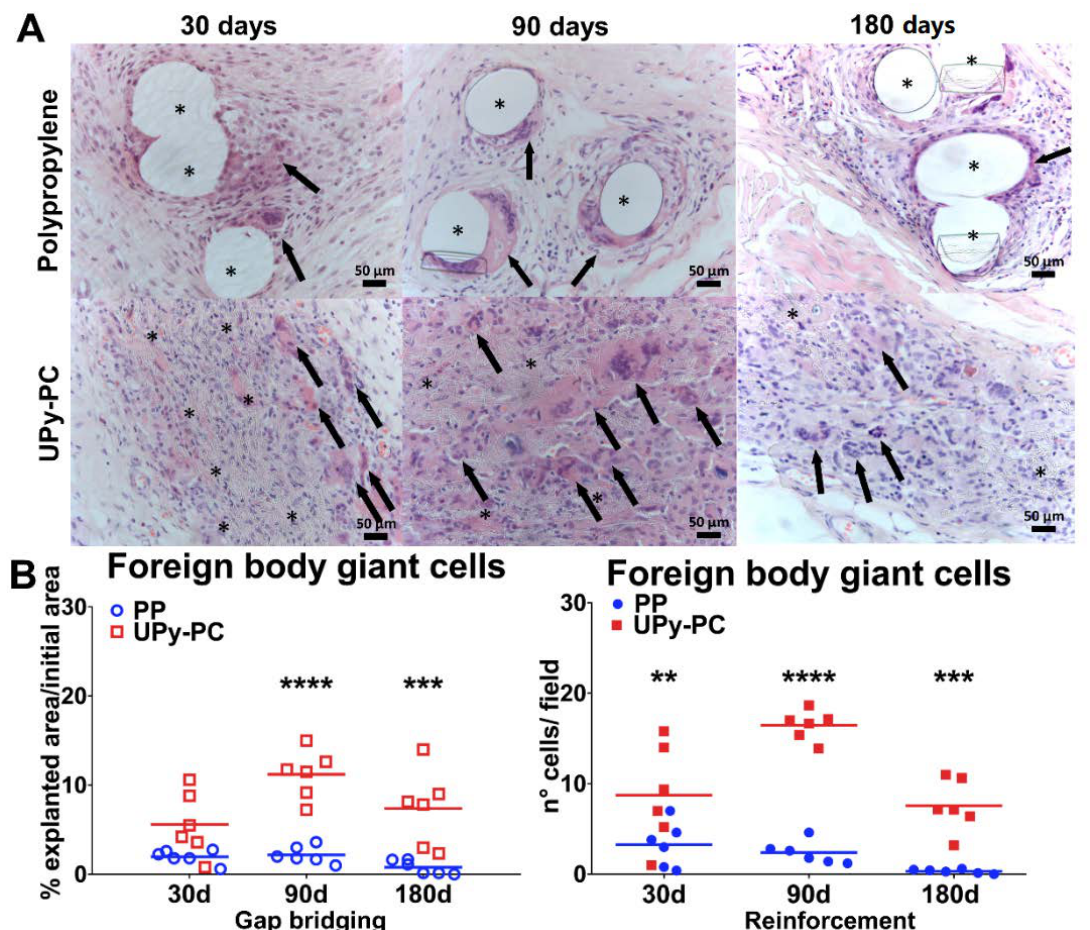
Figure 2. Foreign body response: ( A ) Representative images of H&E stain (200 × magnification) at the mesh–tissue interface. Mesh fibres, large white spaces in the case of polypropylene and thin fibres in the case of UPy-PC, are marked by asterisks. Foreign body giant cells (FBGC; black arrows), were more abundant in UPy-PC specimens. In the areas with a lower presence of UPy-PC fibres, due to degradation, FBGC were also less present. ( B ) Graphs of FBGC counts of gap bridging (left) and reinforcement (right). At all the time points and in both models, counts of FBGC were higher in UPy-PC explants (red). ** p ≤ 0.01, *** p ≤ 0.001 and **** p ≤ 0.0001. FBGC counts from UPy-PC recurrence are represented by light pink. PP: Polypropylene; UPy-PC: electrospun ureidopyrimidinone